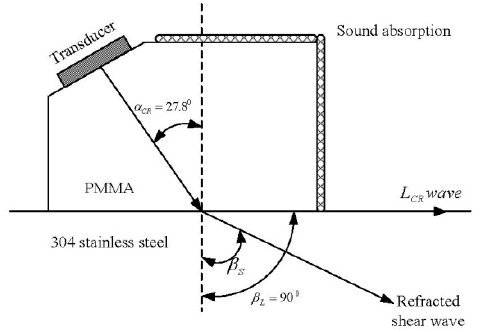
Figure 1. Generation of L CR waves. PMMA: polymethyl methacrylate.